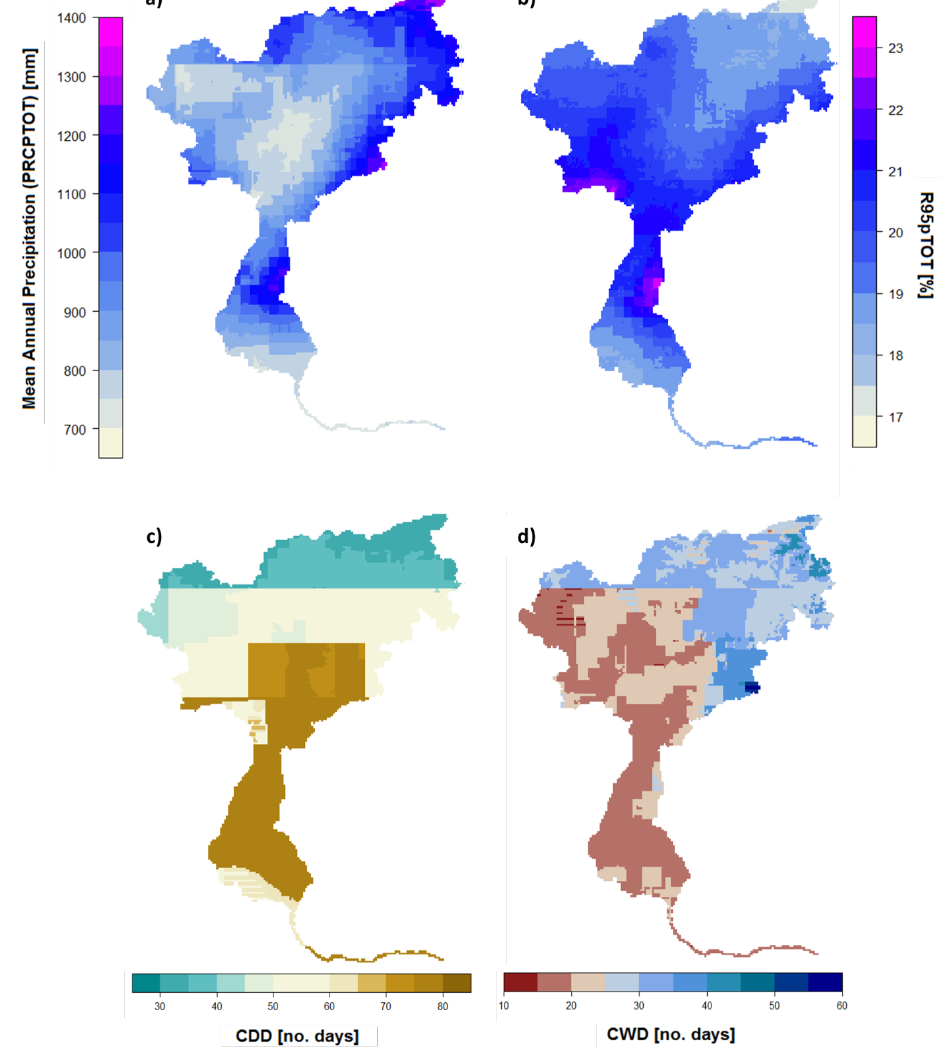
Figure 12. Indicators for the selected grids ensemble, ( a ) mean annual precipitation in mm; ( b ) R95pTOT in %; ( c ) CDD in number of days; and ( d ) CWD in number of days.